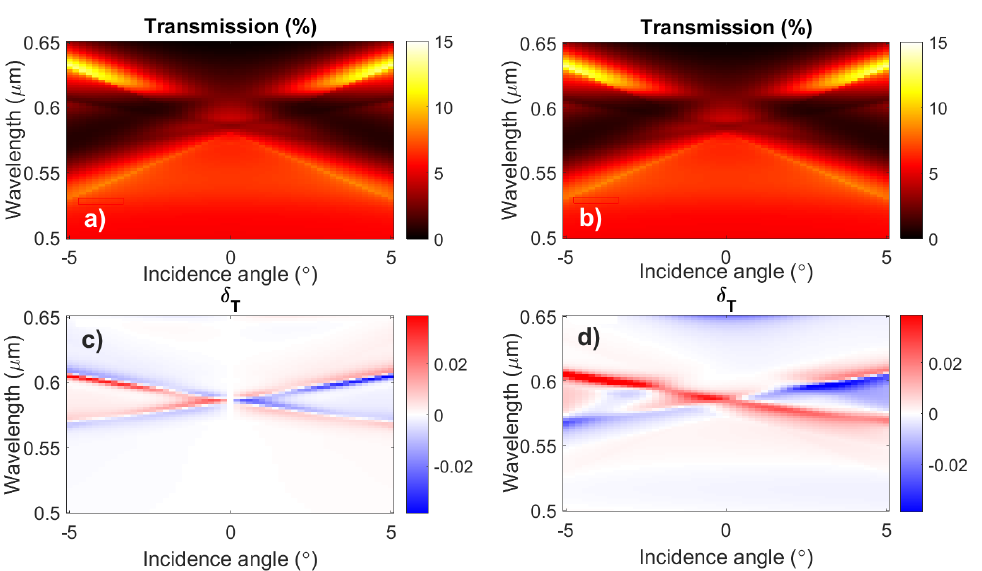
Figure 6. Angular and wavelength-resolved transmission ( a , b ) and δ T ( c , d ) spectra of the nanos- tructure near the waveguide modes excitation area with (right column) and without (left column) the spatial modulation of the magnetization in the ferrimagnetic layer. The phase shift between the plasmonic grating and the magnetization modulation is